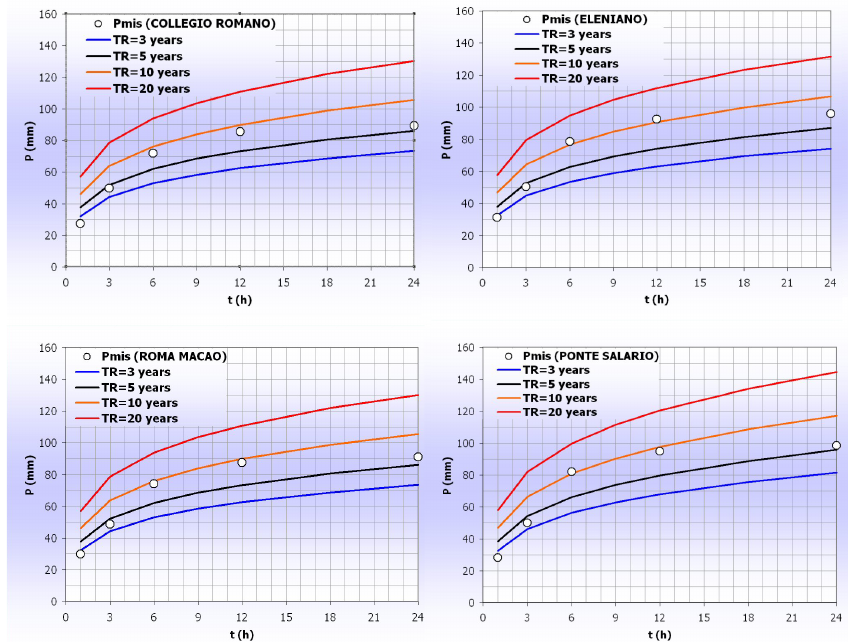
Fig. 3. Precipitation return periods for four rain gauges in the Rome urban area, as a function of the accumulation time.